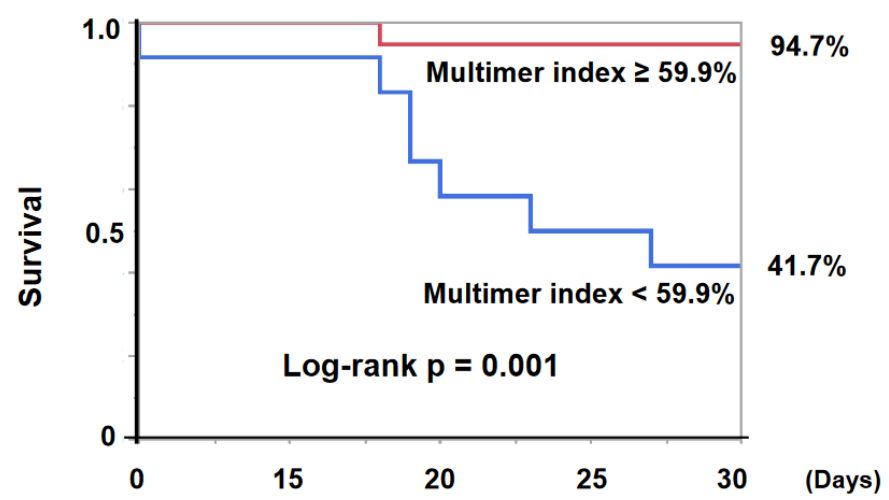
Figure 4. 30-day survival was significantly lower in the low-vWF, large-multimer index (<59.9%) group compared with not low index ( ≥ 59.9%) group (41.7% vs 94.7%, log-rank p = 0.0010). vWF—von Willebrand factor.